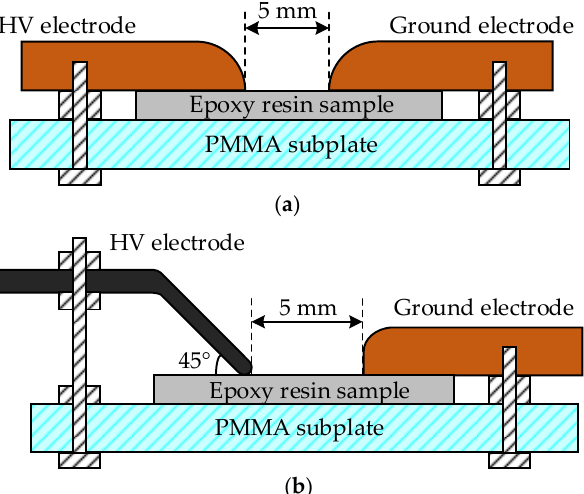
Figure 1. Structure of electrode systems. ( a ) Finger-type electrode system. ( b ) Needle-plate electrode system.